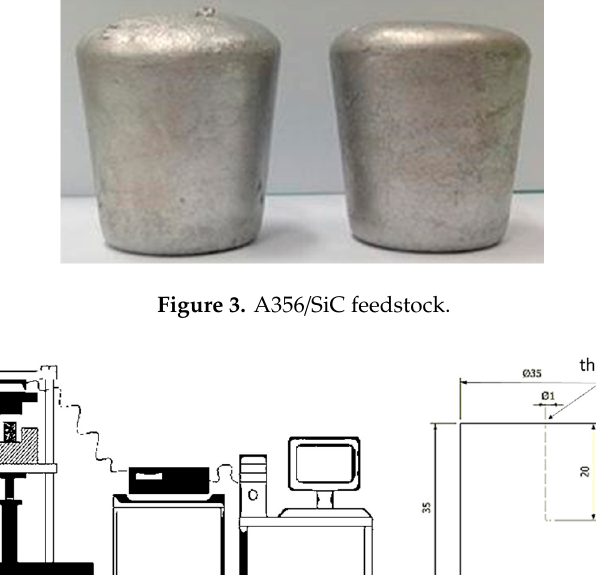
Figure 3. A356 / SiC feedstock .